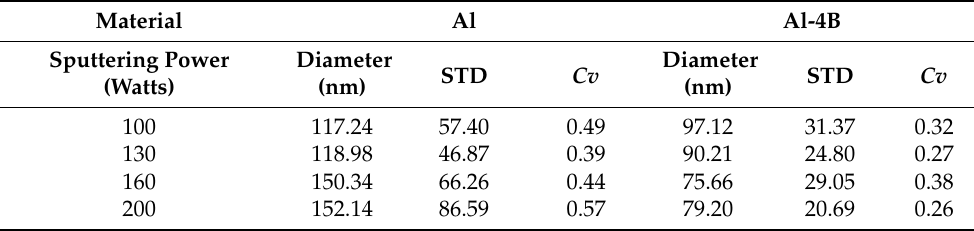
Table 3. Average grain size results for 500 nm thick aluminum and Al-4B films, with thickness sputtered at 100, 130, 160, and 200 W.